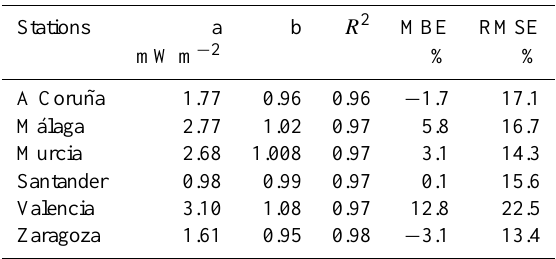
Table 6. Model results at each location considering solar depen-